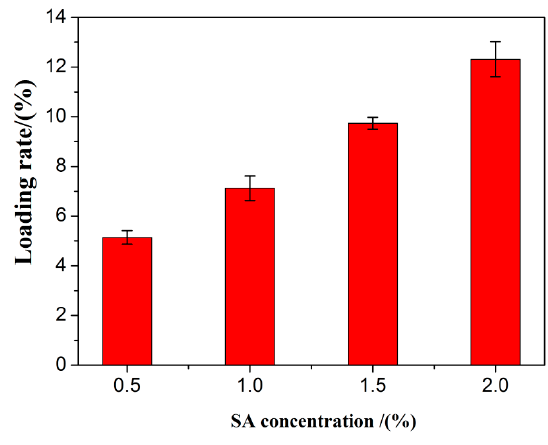
Figure 3. E ff ect of SA concentration on SA loading rate on Figure 3. Effect of SA concentration on SA loading rate on LS.